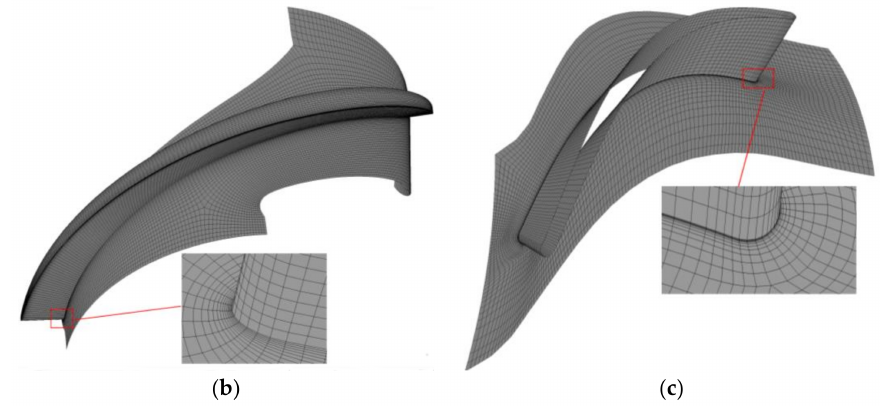
Figure 3. Structured mesh for analysis. ( a ) Computational domain; ( b ) Impeller; ( c ) Guide vane.